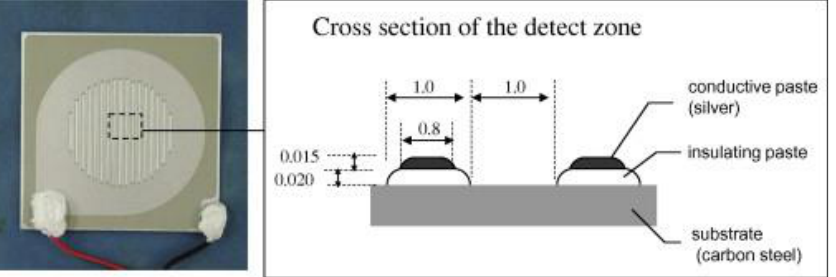
Figure 10. Fe – Ag-type atmospheric corrosion monitor (ACM) sensor (reproduced with permission Figure 10. Fe–Ag-type atmospheric corrosion monitor (ACM) sensor (reproduced with permission from Reference [26]). from Reference